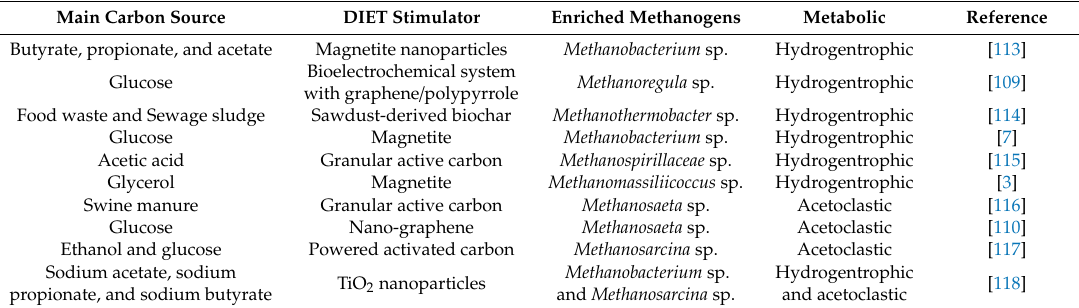
Table 4. The enrichment of methanogenic consortia after direct interspecies electron transfer (DIET)